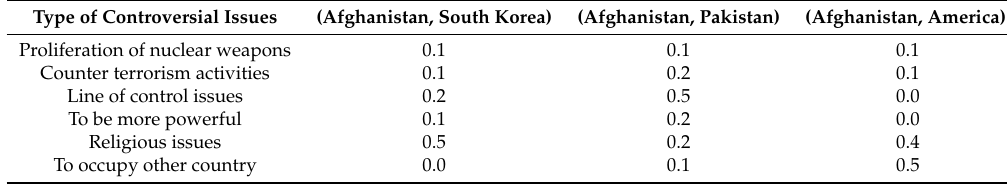
Table 7. Fuzzy set of controversial issues between Afghanistan and other countries.